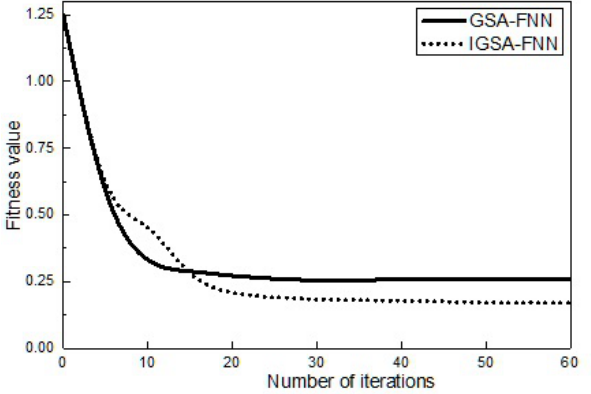
Fig. 5 Fitness curve of GSA-FNN before and after improvement